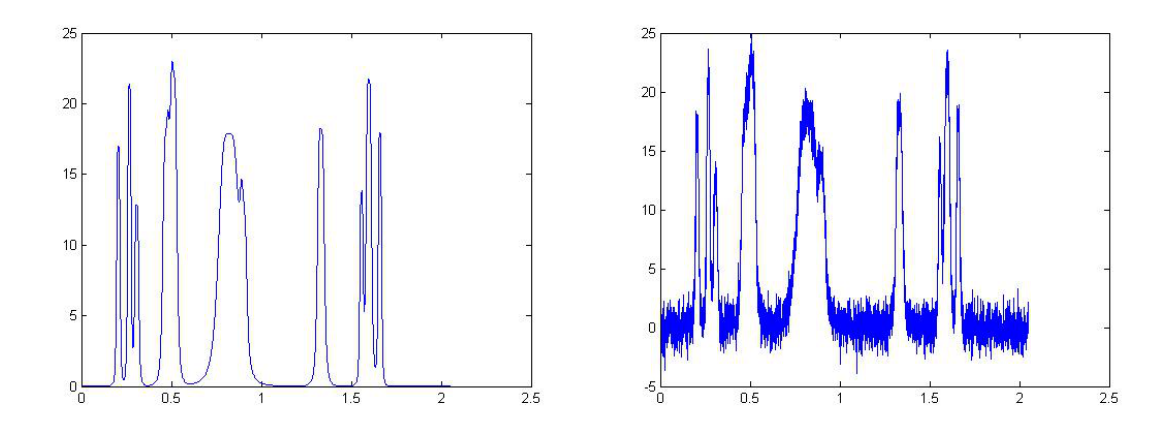
Figure 1: Left: Original Signal. Right: noisy bump.